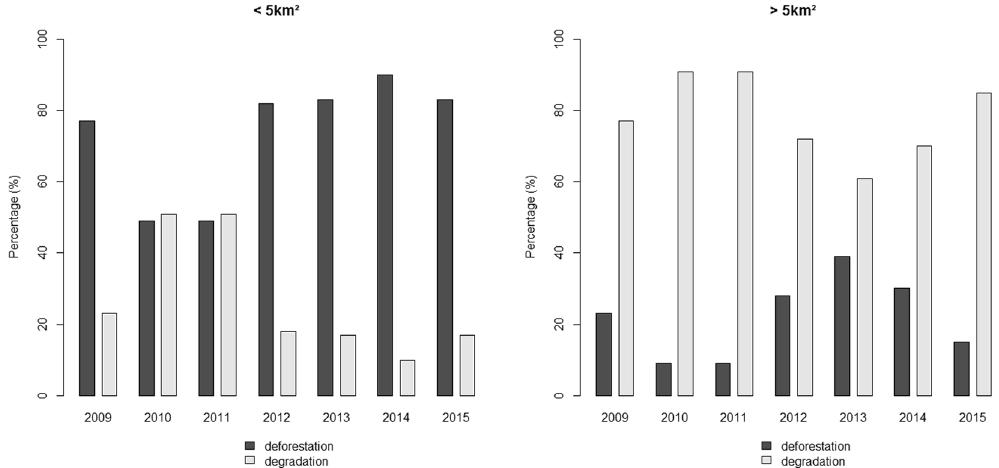
Figure 4. Percentage of the number of polygons of deforestation (dark grey) and degradation (light grey) with areas of less than 5 km² (left panel) and greater than 5 km² (right